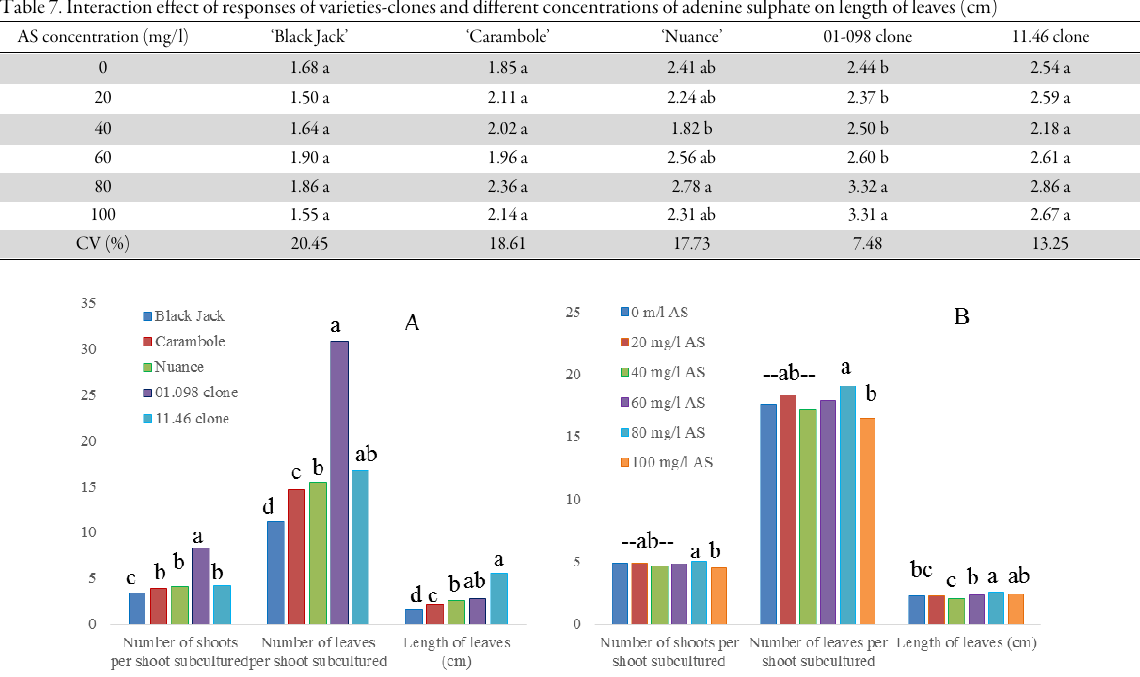
Fig. 3. Effect of different concentrations of AS and responses of gerbera varieties-clone on shoot proliferation. A. Effect of different varieties-clones on shoot proliferation. B. Effect of AS concentrations on shoot proliferation, B. Histograms followed by the same letter in the same cluster are not significant different based on Tukey test,